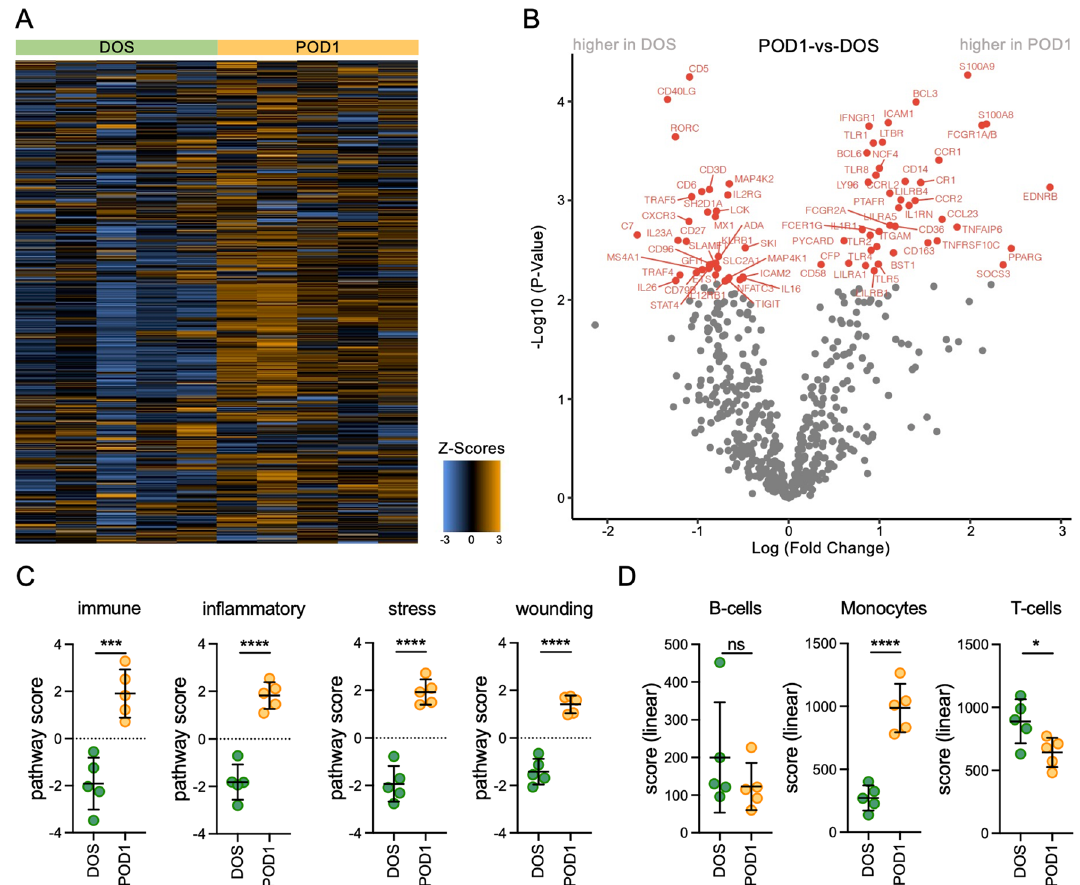
Figure 2. NanoString gene expression analyses of the responses to surgery of peripheral blood mononuclear cells. ( A ) Heatmap representation generated via unsupervised clustering of the normalized gene expression analyses from RNA isolated from peripheral blood mononuclear cells (PBMCs) obtained the day of surgery (DOS) and at 24 h after surgery (POD1) from 5 patients undergoing total knee arthroplasty (TKA) for knee osteoarthritis (OA). Each column represents data from samples collected from one patient on the DOS or at POD1. Each row represents relative gene expression. Orange indicates high expression, and blue indicates low expression. Data were Z-score normalized, scaled to give all genes equal variance. ( B ) Volcano plot representation of the differentially expressed genes (red, p < 0.05) comparing POD1 to DOS. ( C ) Representation of the pathway scores for the immune response, inflammation response, response to stress, and response to wounding in PBMCs isolated from DOS and POD1 whole blood. ( D ) Representation of the linear scores for B-cells, monocytes, and T-cells in PBMCs isolated from DOS and POD1 whole blood. Data are represented as means ± S.D. (error bars). Graphs were created with GraphPad Prism 8 (GraphPad Software, San Diego, CA). * p < 0.05 ** p < 0.001, *** p < 0.0001 and **** p < 0.00001 by t-test. ns indicates not